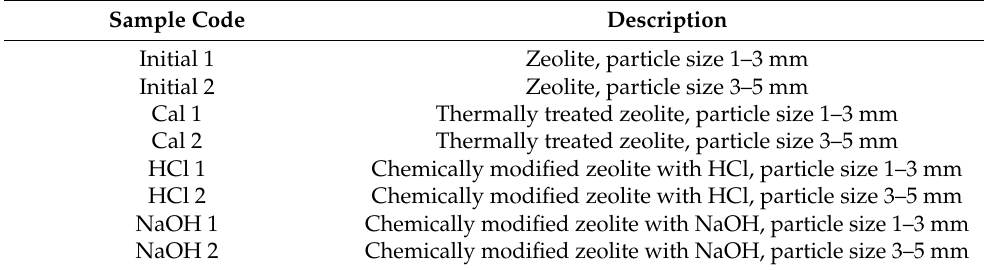
Table 1. Tested zeolite